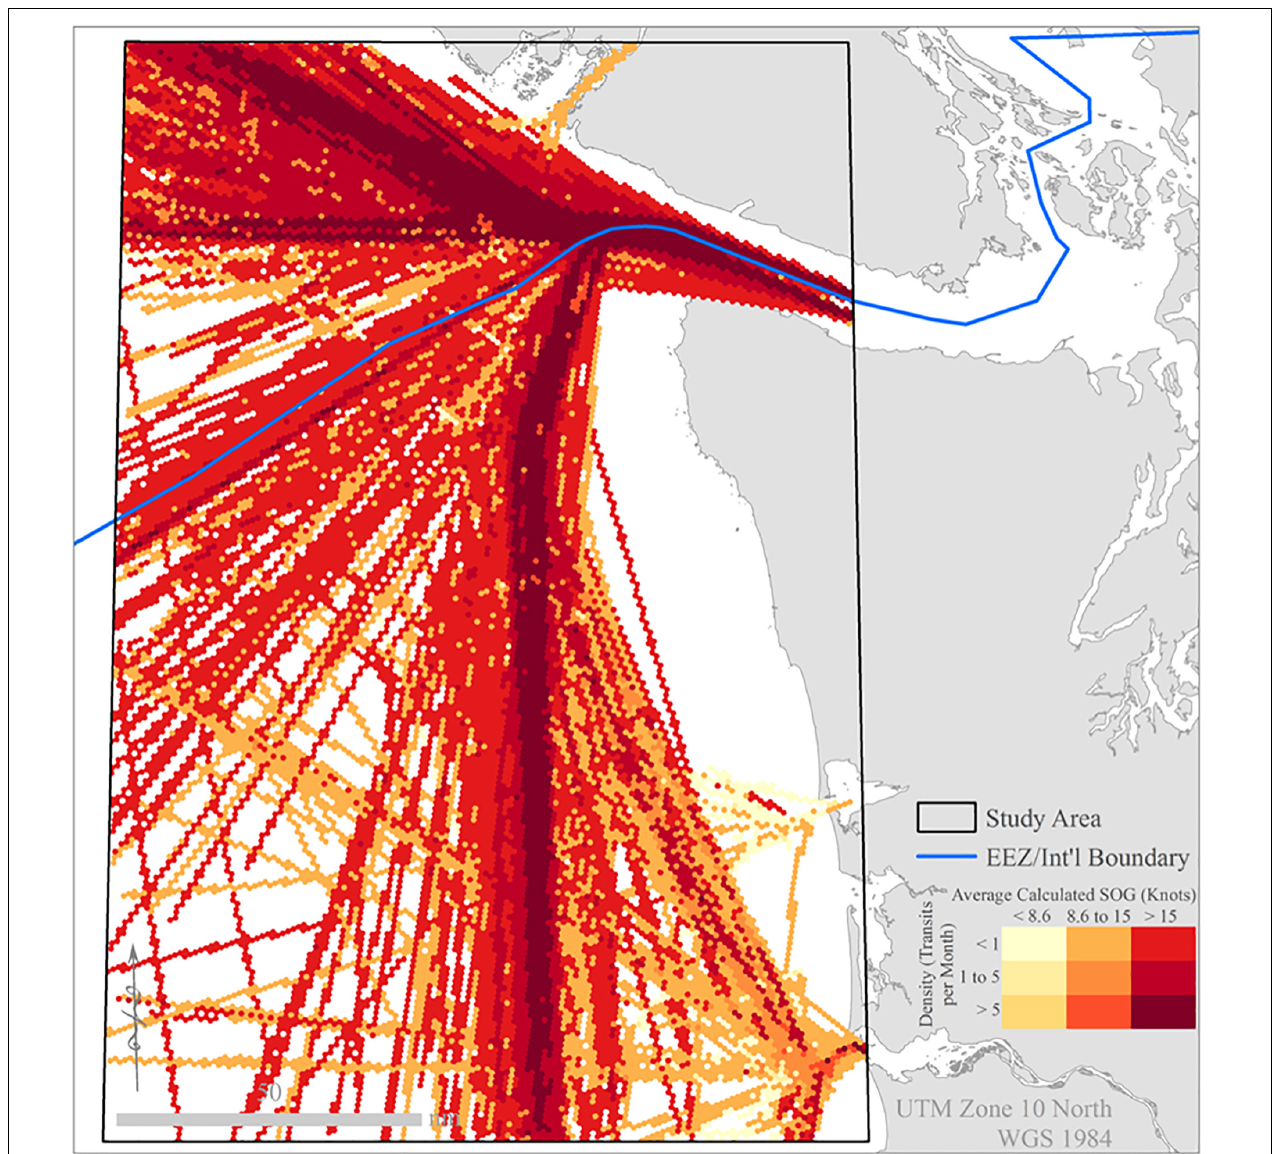
FIGURE 5 | Container ship calculated speed over ground (SOG) and transits per month for 2013 and 2014. The area northwest of the blue Exclusive Economic Zone (EEZ) exhibits high vessel speed and density, although it was not included in the Biologically Important Area (BIA)